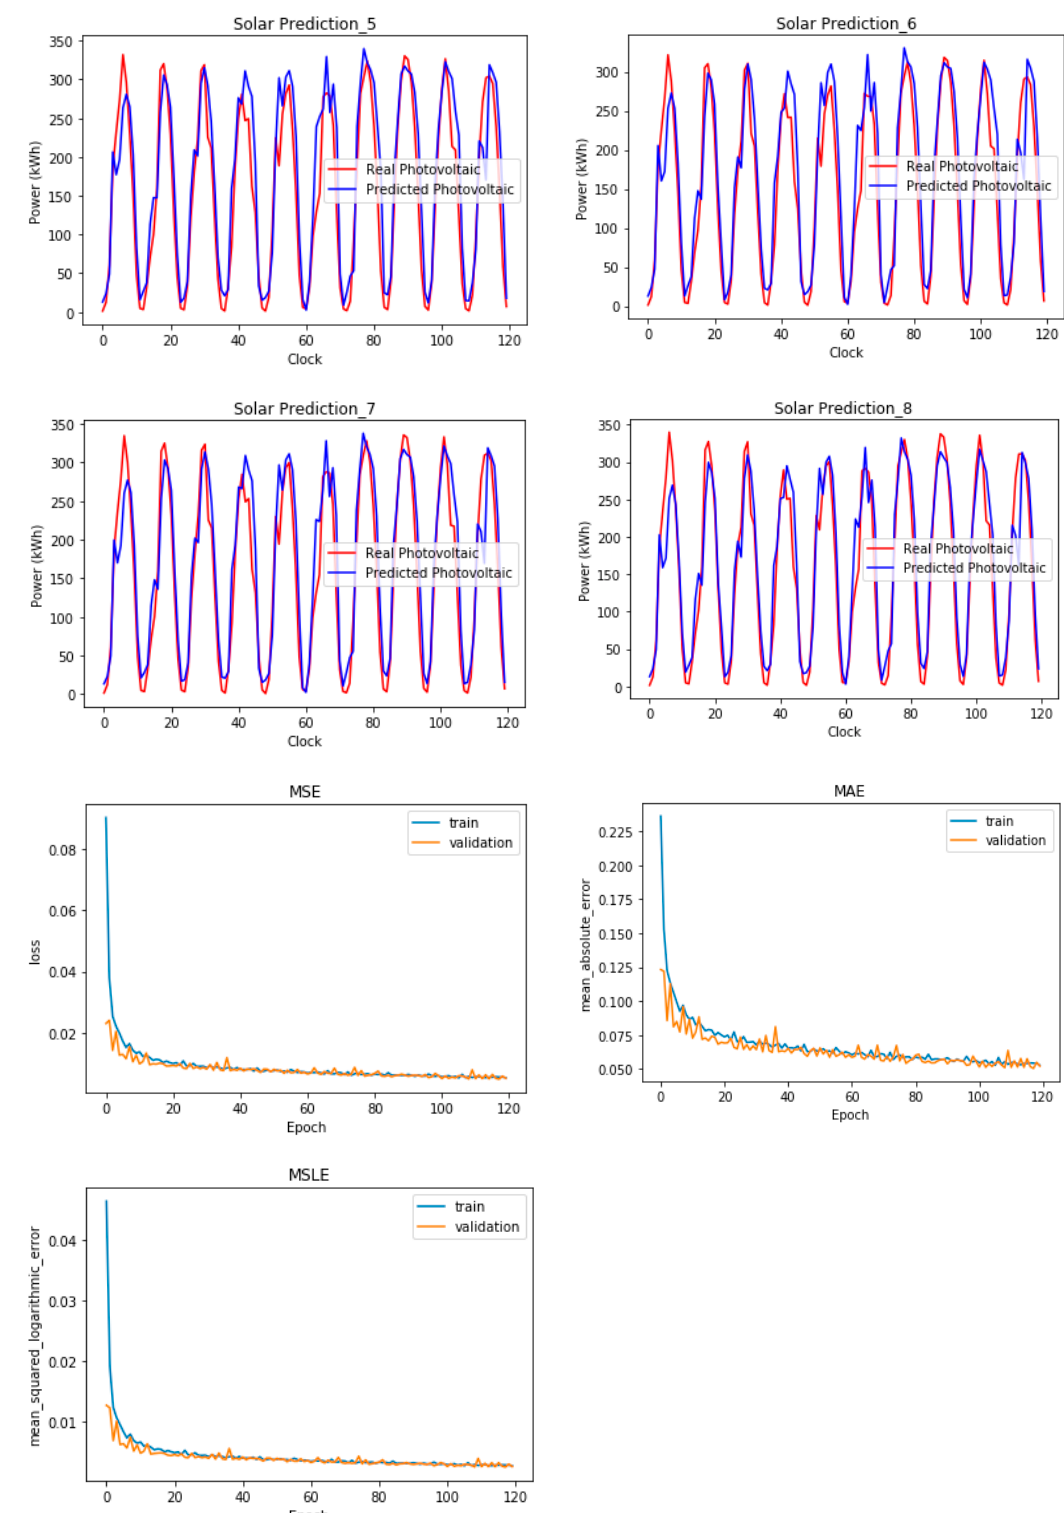
Figure 8. Multiple inverters and model predictions with the same A-11 feature variable information (BiRNN).